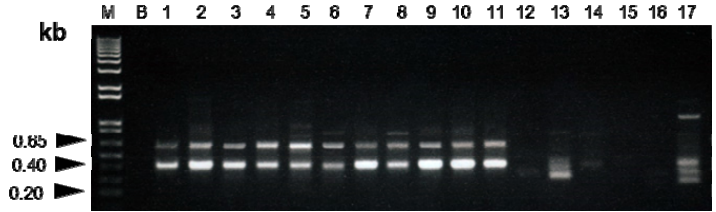
Figure 1. RAPD profiles of Fritillaria species amplified with primer S158. The specific